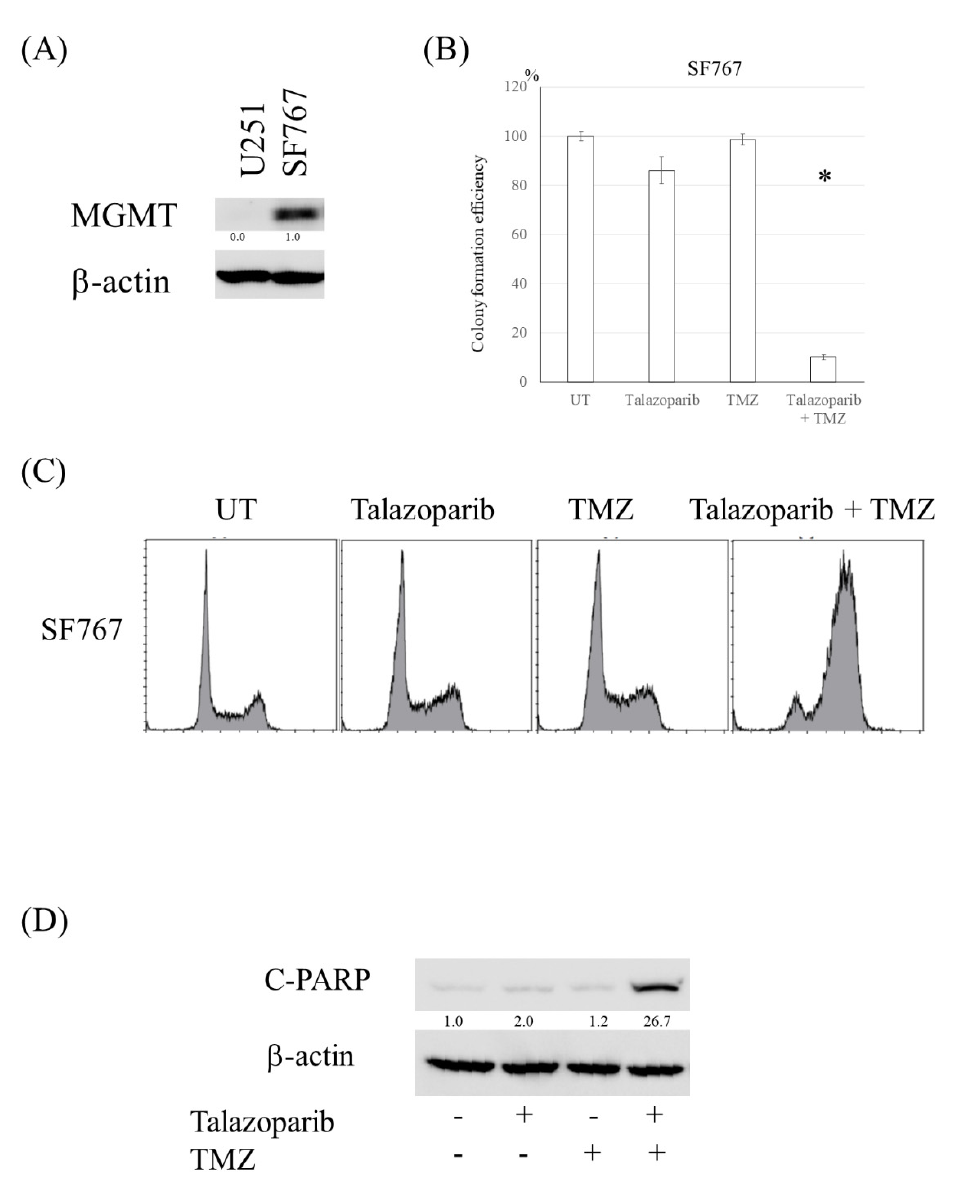
Figure 4. PARP inhibitor resensitized cells with high expression of MGMT to TMZ. ( A ) Western blot analysis of MGMT and β -actin levels in SF767 cells. U251 was used as negative control for MGMT expression. ( B ) Colony formation efficiency of SF767 cells following talazoparib (2.5 nM, 4 days), and/or TMZ (100 µ M, 3 h). ( C ) Fluorescence-activated cell sorting analysis of cell cycle distribution in SF767 cells after talazoparib and/or TMZ exposure. ( D ) Western blot analysis of cleaved PARP and β -actin levels in SF767 cells treated with talazoparib and/or TMZ. *, p < 0.05.